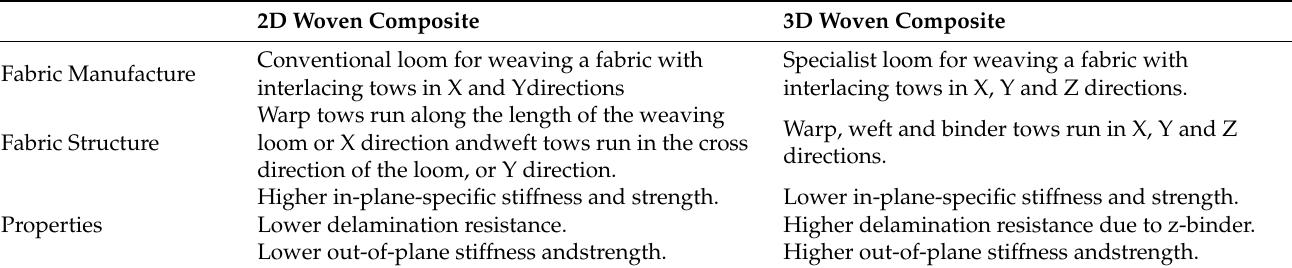
Table 1. Comparison of 2D and 3D woven composites.